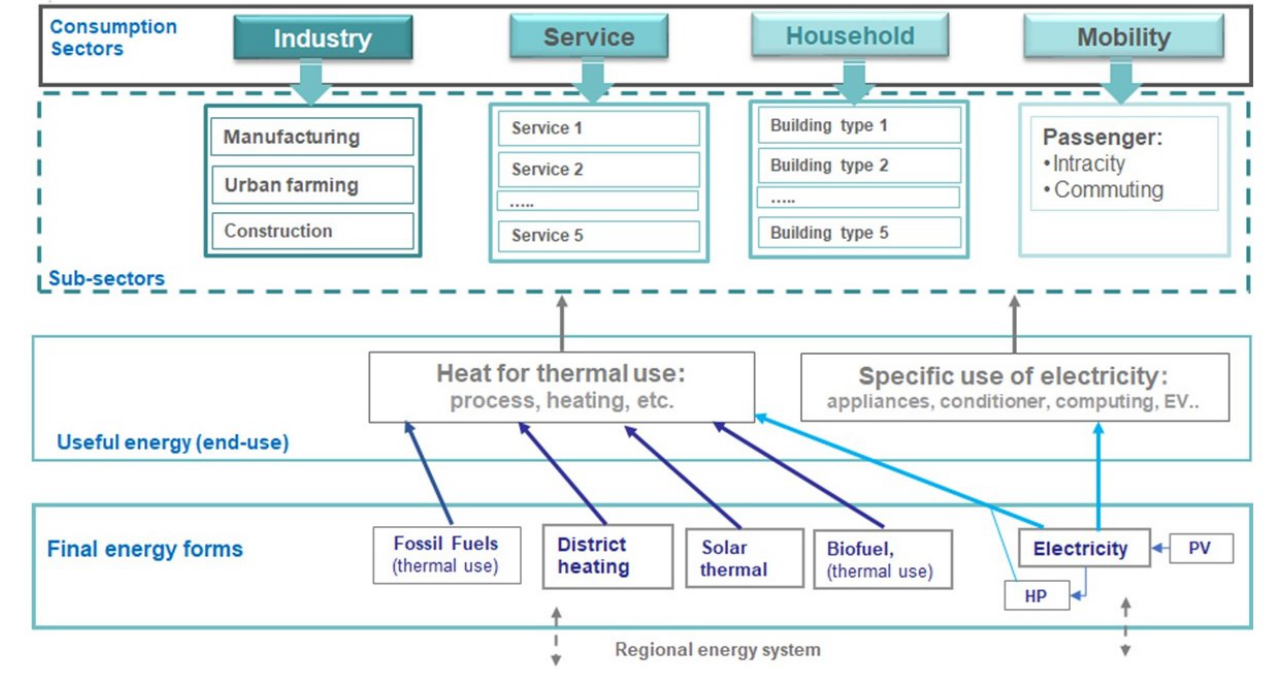
Figure 3. MAPED (Model for Energy Analysis of Positive Energy District) concept for the disaggregation of district energy demand, by fuel and consumption sectors (source: AIT); HP—heat pump,